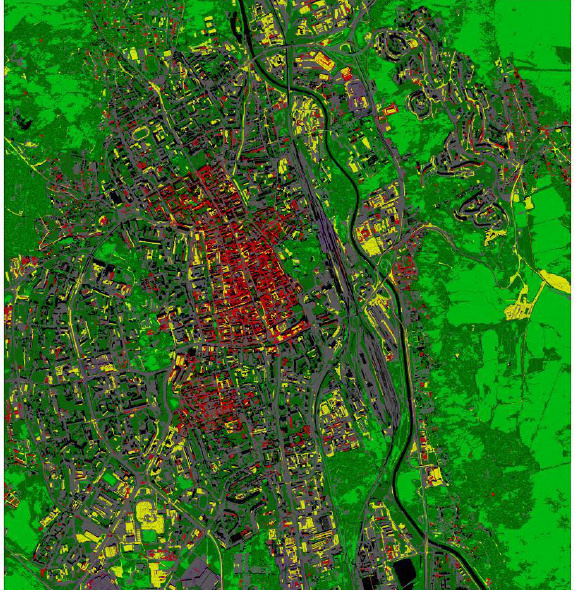
Figure 3. Small scale level classification, the city of Košice, light and dark green represent low and high vegetation respectively, grey represents tar areas, red areas are red roofs, black is for dark objects and yellow represents other